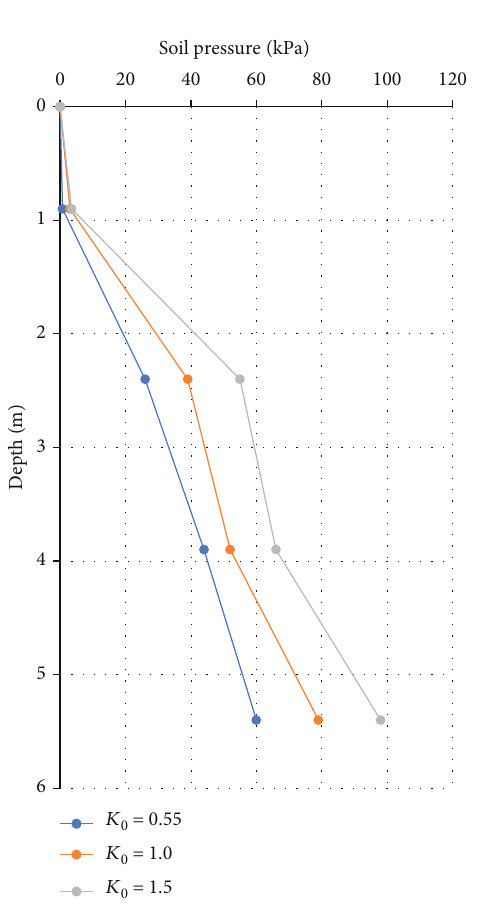
Figure 11: Soil pressure at di ff erent depth of trench with di ff erent K 0